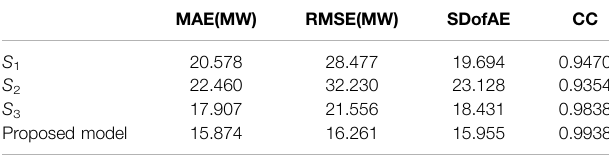
TABLE 1 | Four error metrics of different prediction methods MAE(MW)